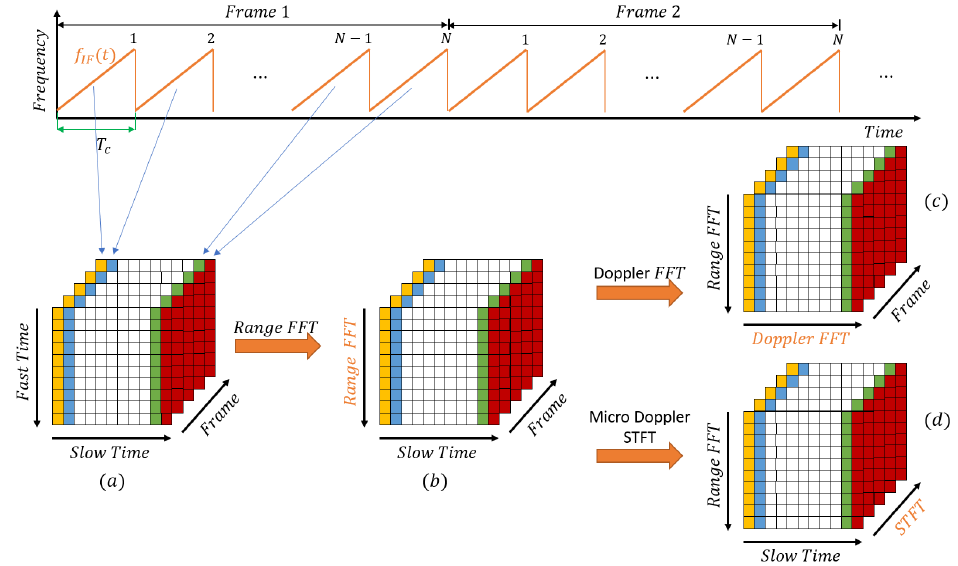
Figure 4. FMCW processing flow from the IF signal, assembled in matrix bins. Data are produced according to a frequency bin size ( a ) collected over the chirps. An FFT is directly applied for each chirp (fast time), creating the range FFT matrix ( b ). A second FFT over the chirp indexes (slow time) produces the range-Doppler frames ( c ), while micro-Doppler results from STFT on the chirp index over the